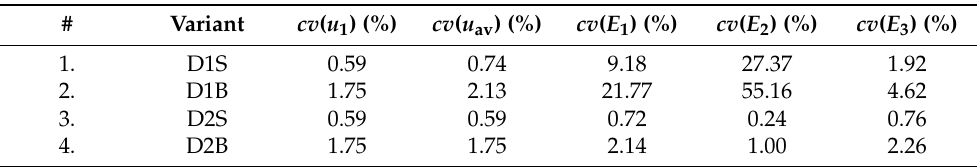
Table 2. Variation coefficient of deflection and stiffness